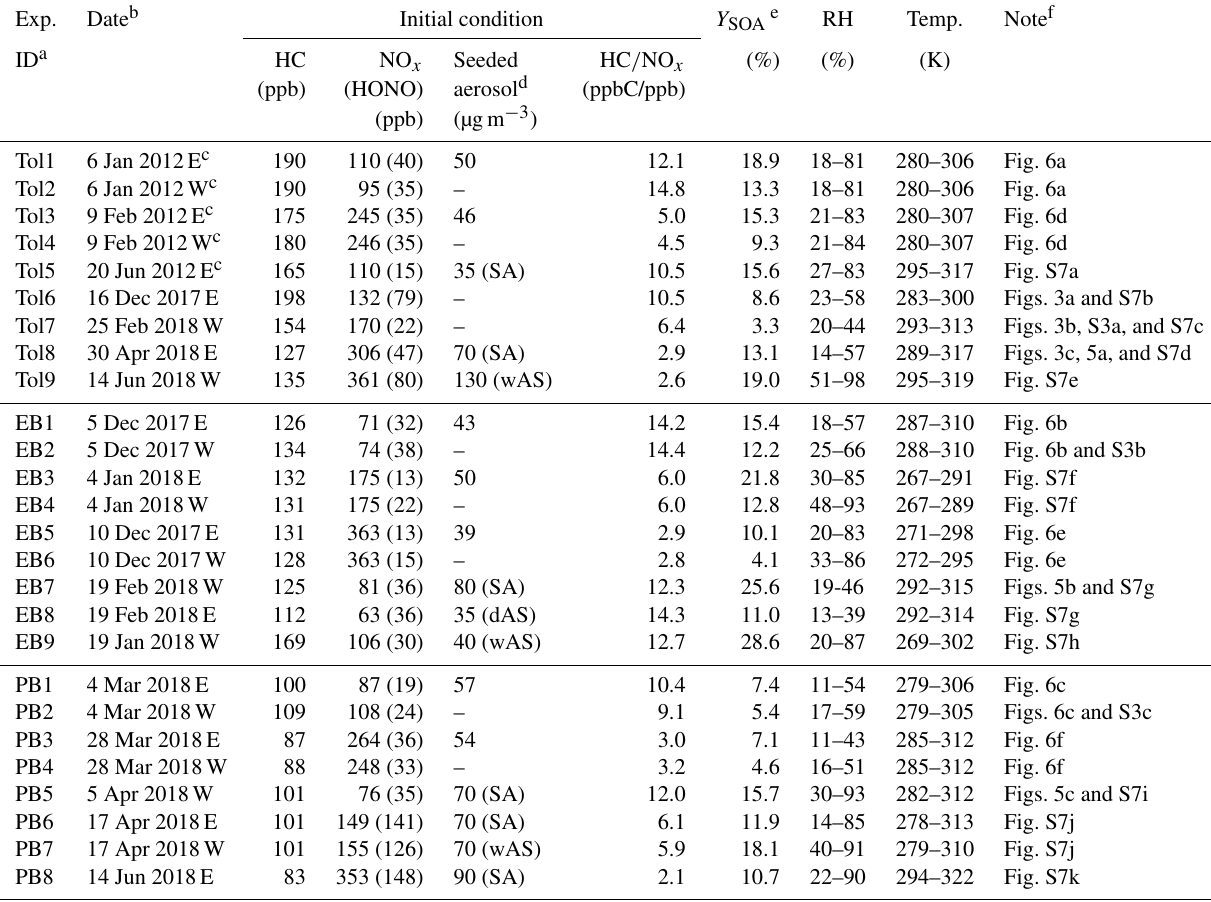
Table 1. Experimental conditions and resulting SOA chamber data from the monoalkylbenzenes photooxidation experiments performed under various NO x conditions with/without inorganic-seeded aerosol in the dual outdoor UF APHOR chambers.